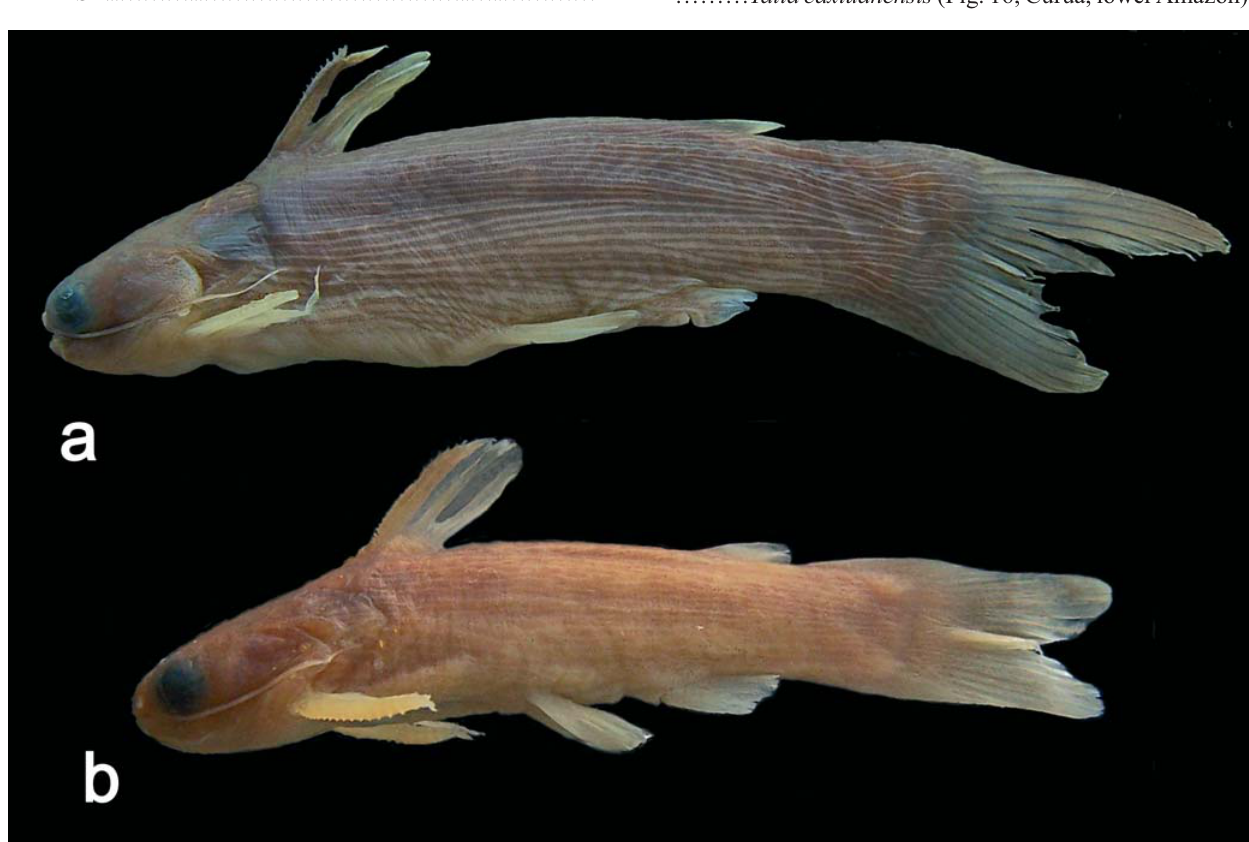
Fig. 40. Tatia strigata. (a) paratype, MCZ 78092, male, 55.0 mm SL, Negro river, Amazonas State, Brazil. (b) paratype, MZUSP 7298, female, 31.2 mm SL, Marau river, Amazonas State,